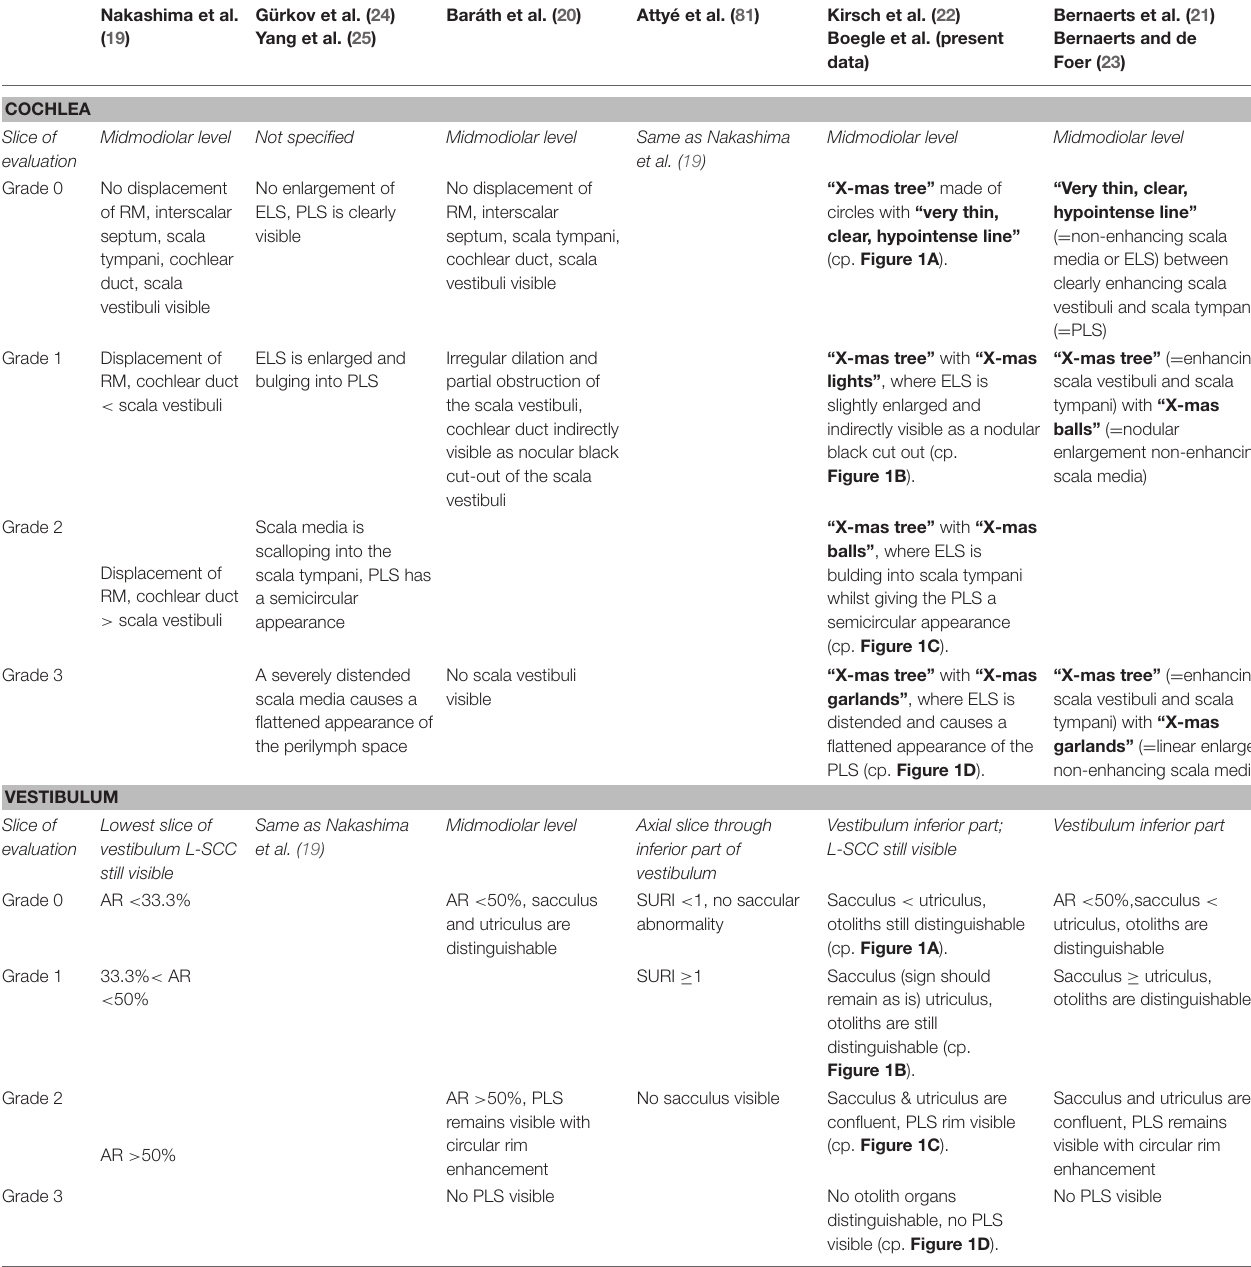
TABLE 1 | Semi-quantitative (SQ) grading conventions at a